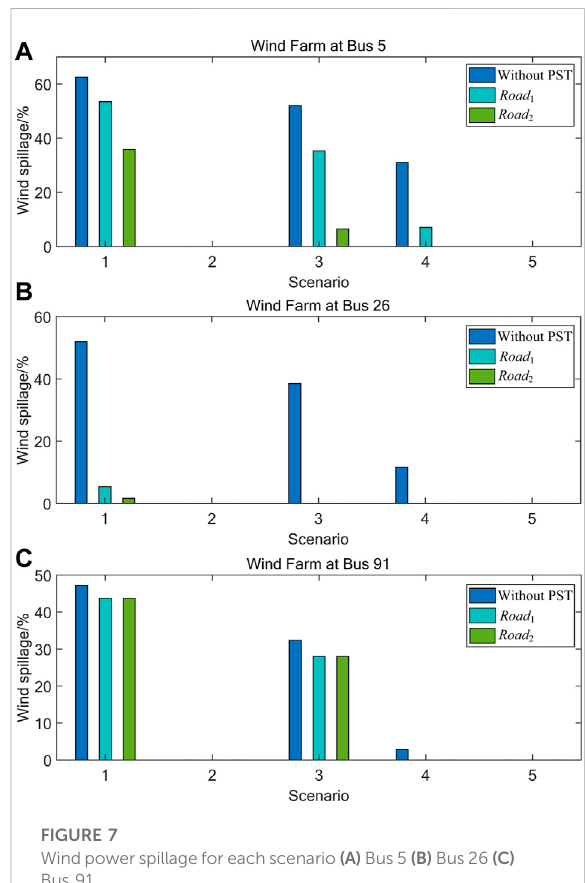
FIGURE 7 Wind powerspillagefor eachscenario (A) Bus5 (B) Bus26 (C) Bus 91.